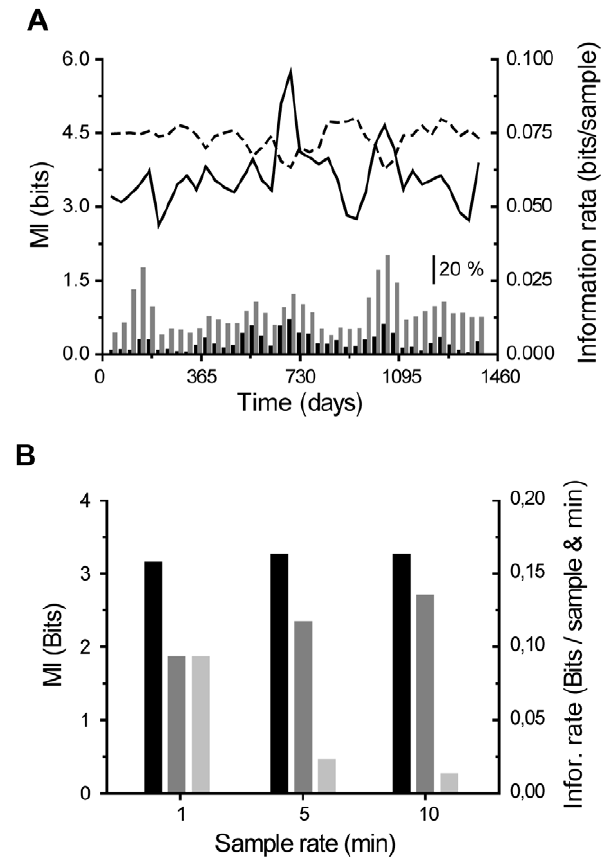
Figure 6. N-parameter selection. No clear linear region is observed if too small N is used in the estimator (black), which would result in an underestimate; too large N gives rise to an erroneous linear range appearing with large d and fitting that region would lead to an overestimate (grey).